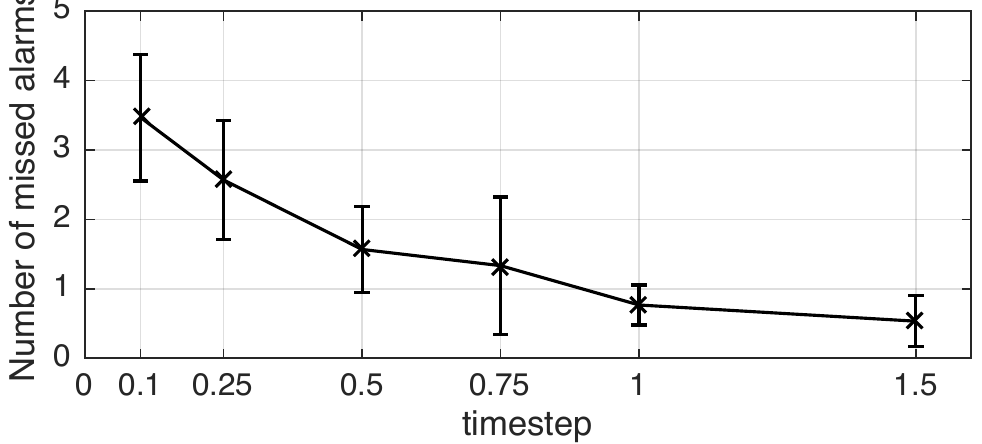
Figure 14. Impact of time step on the number of missed